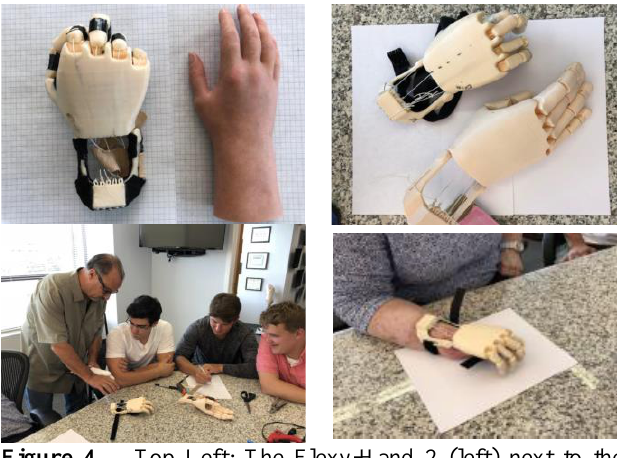
Figure 4. Top Left: The Flexy-Hand 2 (left) next to the modified Flexy-Hand 2 (right): Top Right: The modified Flexy- Hand 2 (bottom) next to the ideal sized hand for this patient (top); Bottom Left: The UPI-Ras Labs’ collaborative team constructing the modified hand; Bottom right: The patient wearing the modified Flexy Hand